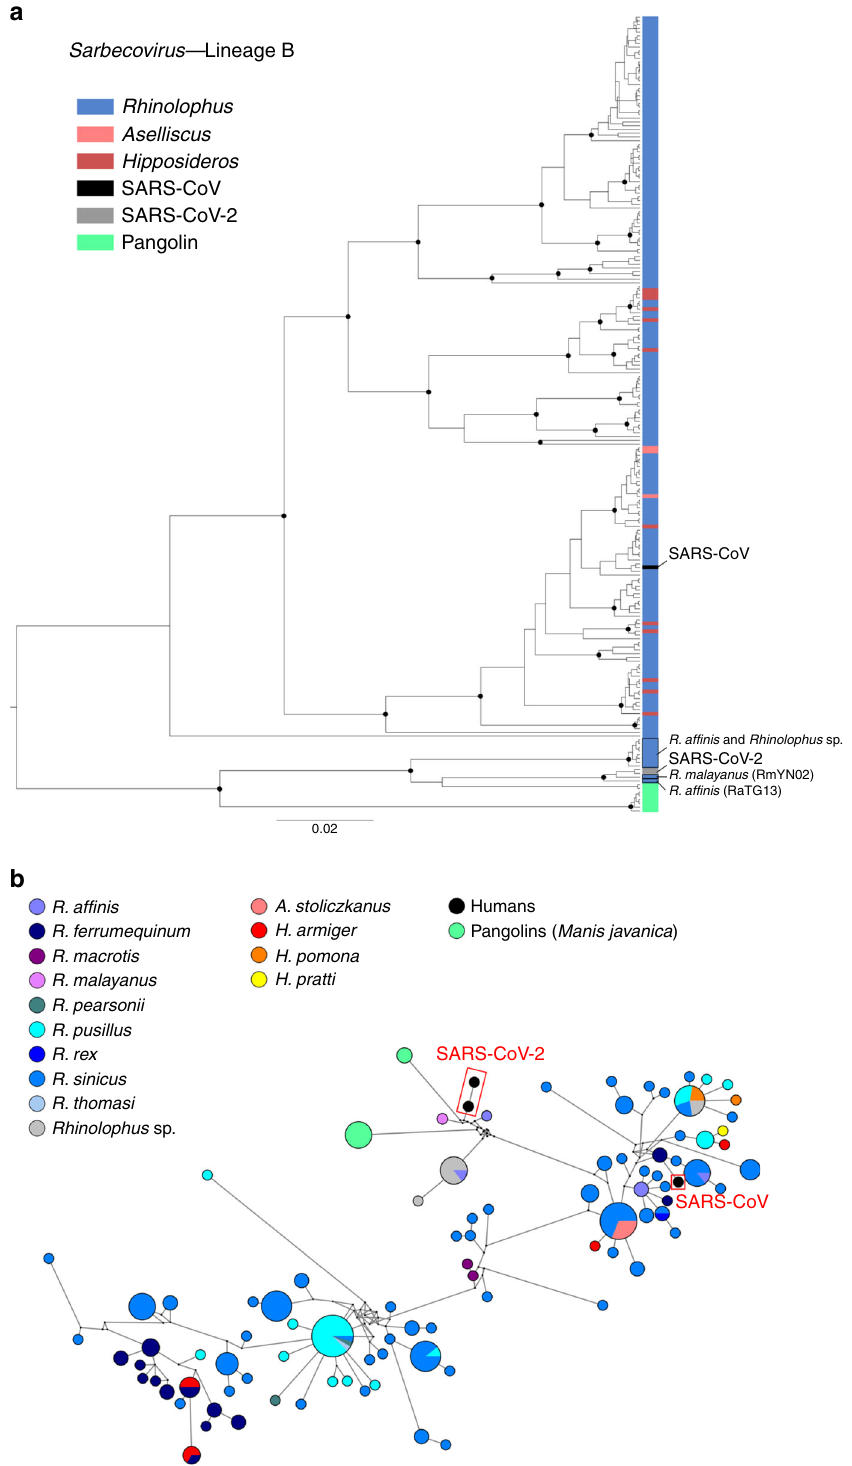
Fig. 3 Phylogenetic relationships within the Sarbecovirus subgenus ( β -CoVs). Maximum clade credibility tree ( a ) including 202 RdRp sequences from the Sarbecovirus subgenus isolated in bats, two sequences of SARS-CoV-2, and one sequence of SARS-CoV isolated in humans and eight sequences isolated in Malayan pangolins ( Manis javanica ). Well-supported nodes (posterior probability > 0.95) are indicated with a black dot. Tip colors correspond to the host genus; SARS-CoV-2 sequences and SARS-CoV sequence are highlighted in gray and black, respectively. Median-joining network ( b ) including 202 RdRp sequences from the Sarbecovirus lineage isolated in bats, two sequences of SARS-CoV-2, and one sequence of SARS-CoV isolated in humans and eight sequences isolated in Malayan pangolins ( Manis javanica ). Colored circles correspond to distinct CoV sequences, and circle size is proportional to the number of identical sequences in the dataset. Small black circles represent median vectors (ancestral or unsampled intermediate sequences). Branch length is proportional to the number of mutational steps between